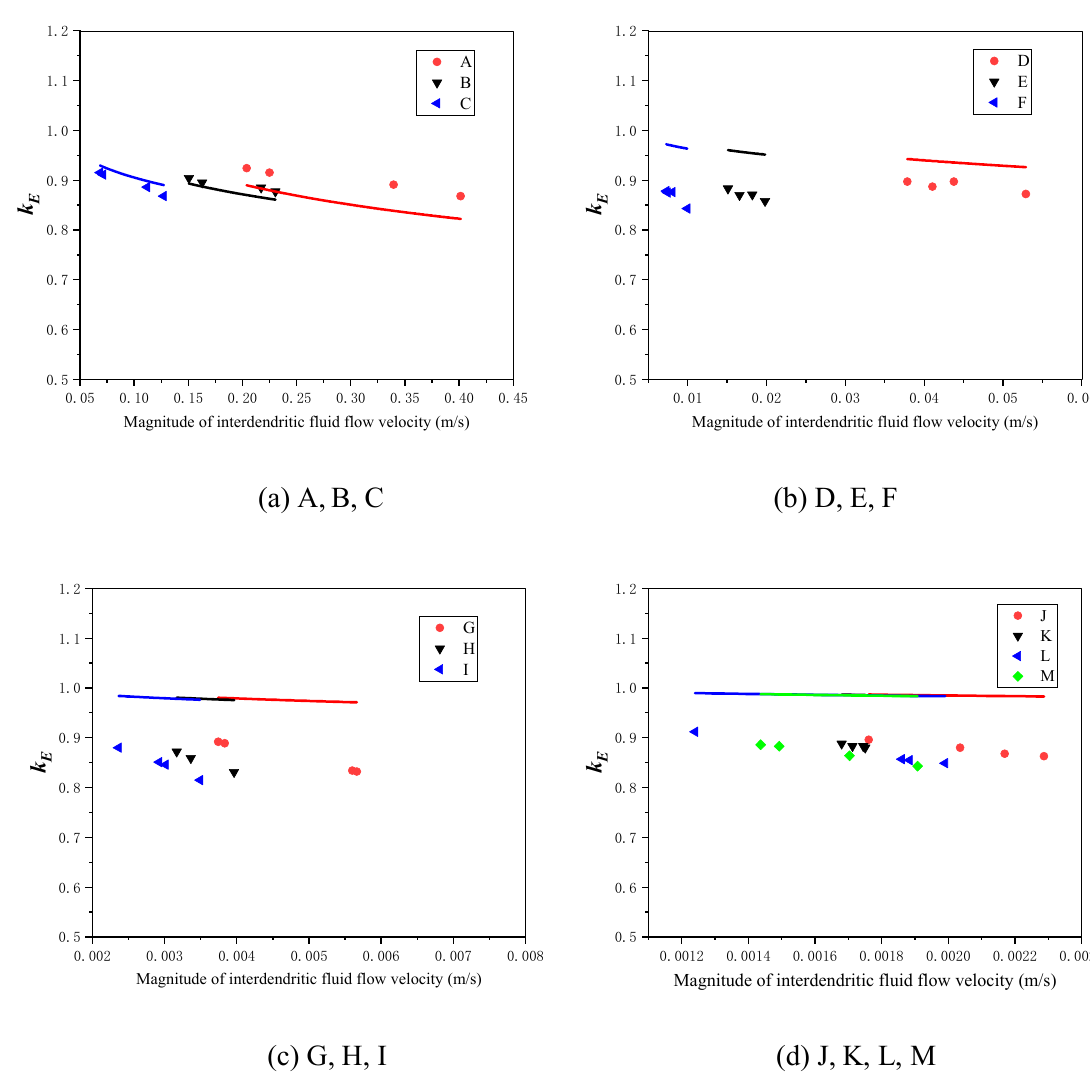
Figure 26. The measured k E by the new approach (the discrete dots of different shapes) and the corresponding empirical k E by Equation (23) (the continuous full line) under different magnitudes of interdendritic fluid flow velocity V if f . ( a ) A, B, C positions, ( b ) D, E, F positions, ( c ) G, H, I positions, ( d ) J, K, L, M positions. (The distance to the bloom edges at A, B, C, D, E, F, G, H, I, J, K, L and M positions are 1, 3, 5, 10, 20, 30, 40, 50, 60, 70, 80, 90, and 100 mm, respectively).